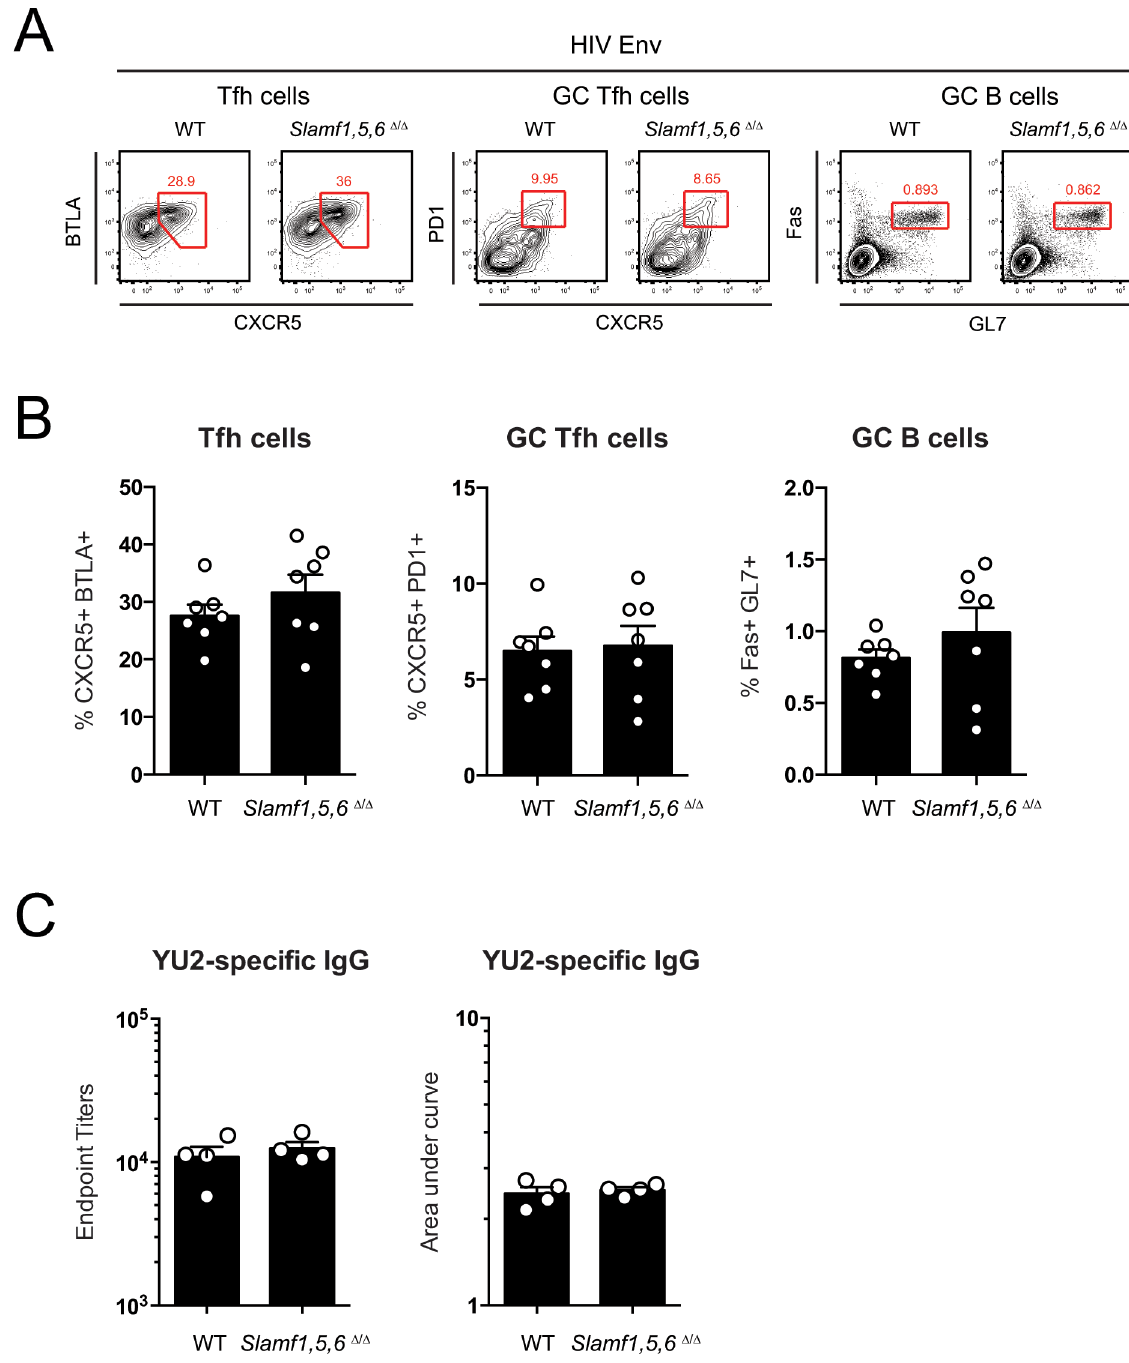
Fig 5. Lack of defects in germinal centers generated in Slamf1 , 5 , 6 Δ / Δ mice after immunization with HIV envelope trimer protein. (A) Flow cytometry plots and (B) graphs of CD19 - CD4 + CD44 + CXCR5 + BTLA + Tfh cells, CD19 - CD4 + CD44 + CXCR5 + PD1 + GC Tfh cells, and CD4 - CD19 + Fas + GL7 + GC B cells in draining popliteal lymph nodes of of WT and Slamf1 , 5 , 6 Δ / Δ mice at 8 days post immunization with HIV Envelope (YU2 gp140-F) protein. (A-B) Data represents two independent experiments, with 3 – 4 mice per grouop. (C) Endpoint titers and Area Under Curve (AUC) analyses of HIV Env (YU2-gp140-F) specific serum IgG at 15 days post immunization with YU2-gp140-F. Data represents one experiment, with 4 mice per group.